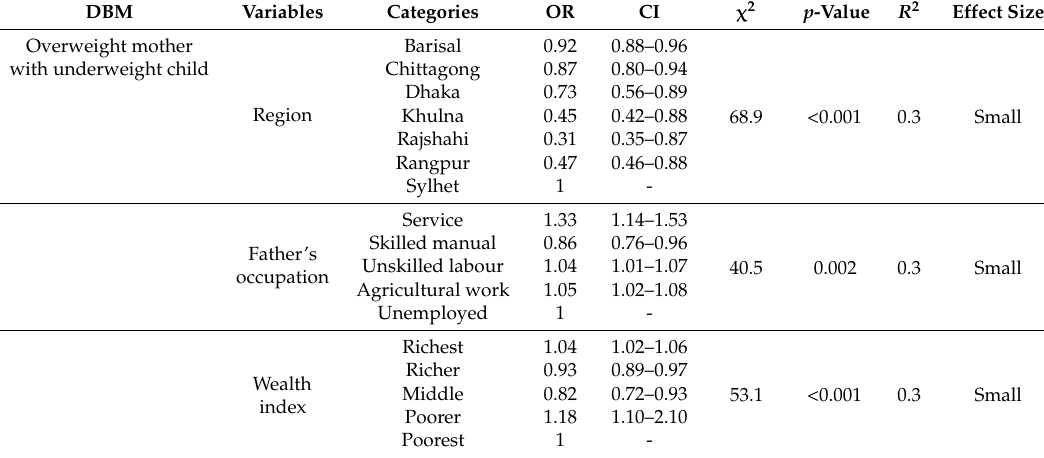
Table 4. Sequential multinomial logistic regression analysis of overweight mother and underweight child pairs by socio-demographic